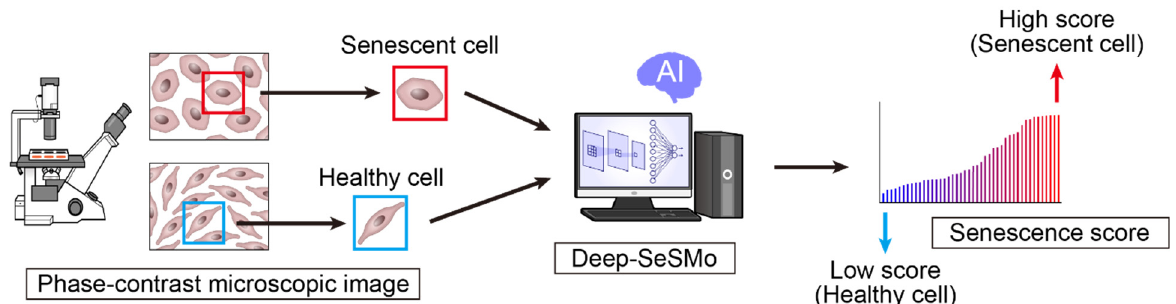
Figure 5. Deep Learning-Based Senescence Scoring by Morphology (Deep-SeSMo).: Deep-SeSMo is an AI-based system that creates senescence scores from phase-contrast microscopy images without molecular labels and can evaluate the degree of cellular senescence in high quantities by applying the senescence probability output from the